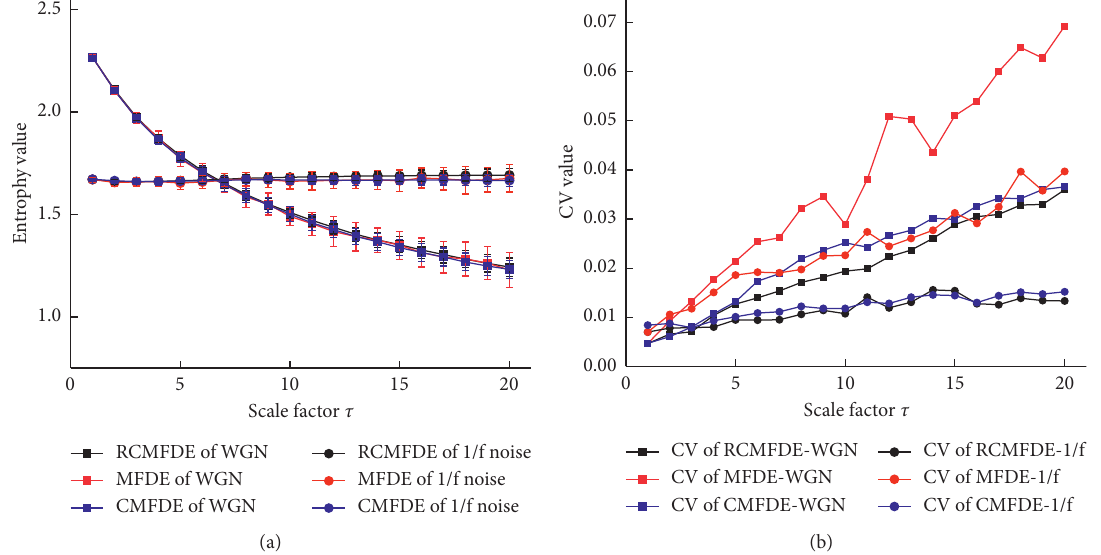
Figure 3: Comparison of RCMFDE, CMFDE, and MFDE. (a) Mean value and SD of WGN and l/f noise using different methods. (b)CV of WGN and l/f noise using different